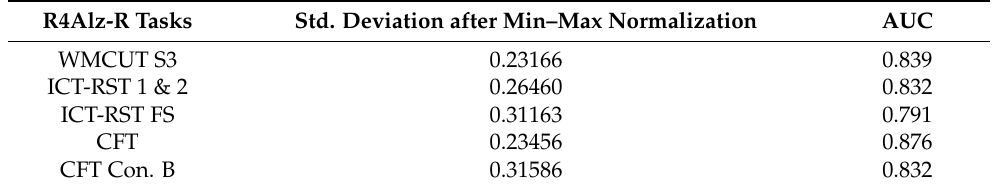
Table 5. Standard deviations of the R4Alz-R battery’s scores of interest for SCD and HC groups.